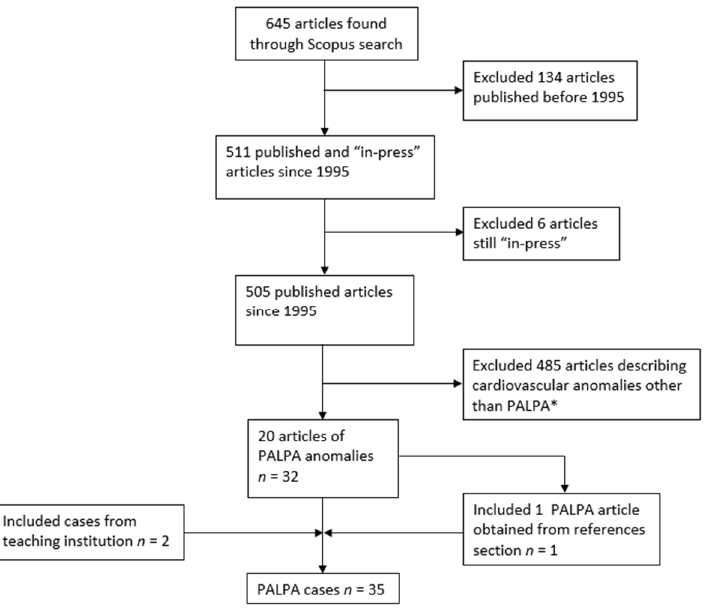
Figure 1. Flowchart depicting systematic article exclusion and overall PALPA case acquisition from the literature and a single teaching institution. * = including but not limited to partial anomalous pulmonary venous connection, left pulmonary artery sling and anomalous coronary artery connection.